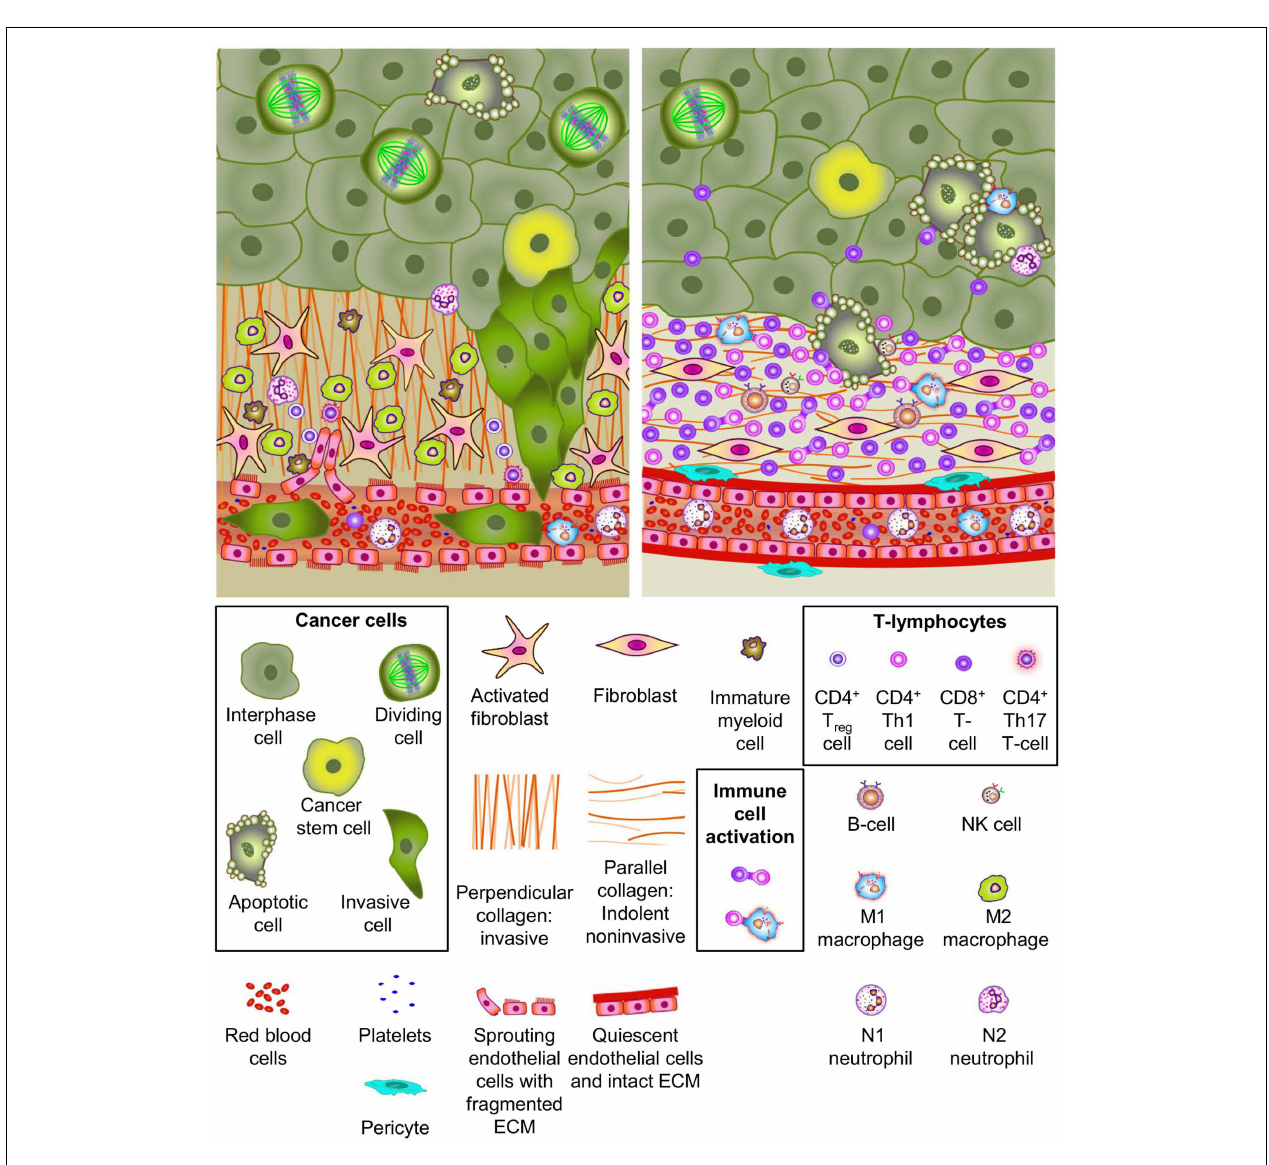
(5) tumor cell invasion and intravasation. Notable tumor promoting immune-cell phenotypes are highlighted. Many of these factors have been demonstrated to contribute to invasive growth and metastatic dissemination of cancer cells.The upper right panel illustrates tumor micro-environment characteristics reported to be associated with a more indolent phenotype. Several important characteristics of indolent tumors including (1) innate immune-cell mediated tumor cell killing, (2) cellular and humoral adaptive immune-cell anti-tumor responses, (3) normal vasculature with pericyte coverage and intact basement membrane, (4) quiescent stroma, and (5) parallel collagen orientation are